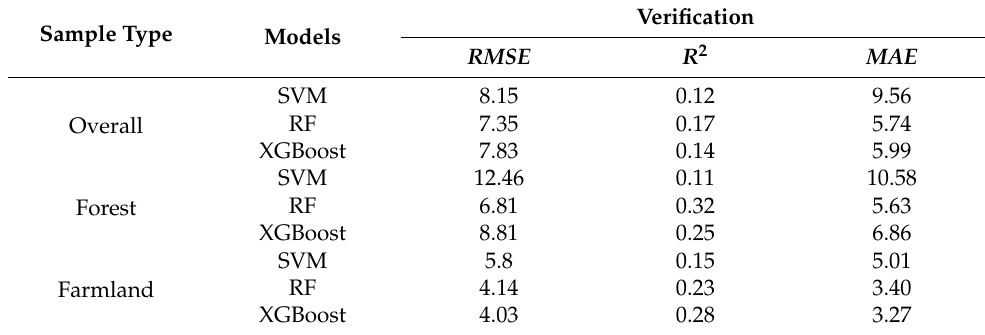
Table 6. SOC prediction accuracy using different simulation models for different land use types.